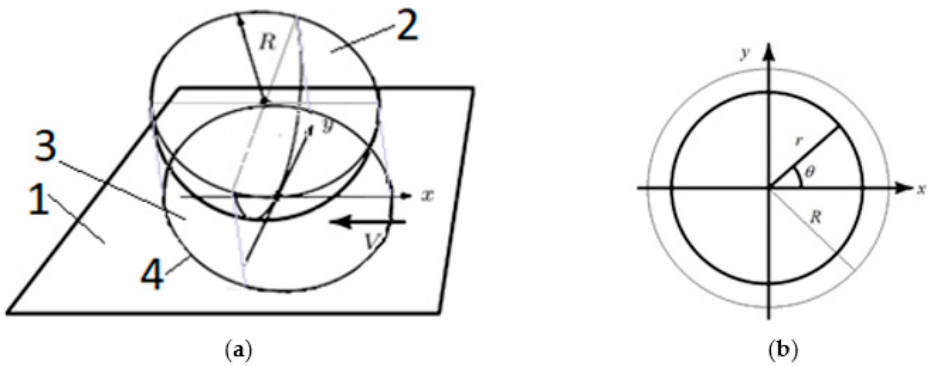
Figure 14. ( a ) Model of plane (1) moving against fixed hemisphere with the speed V. Volume (3) between hemisphere and its projection (4) is filled with lithium grease; ( b ) The polar coordinate system for calculation of hydrodynamic pressure in the volume (3).